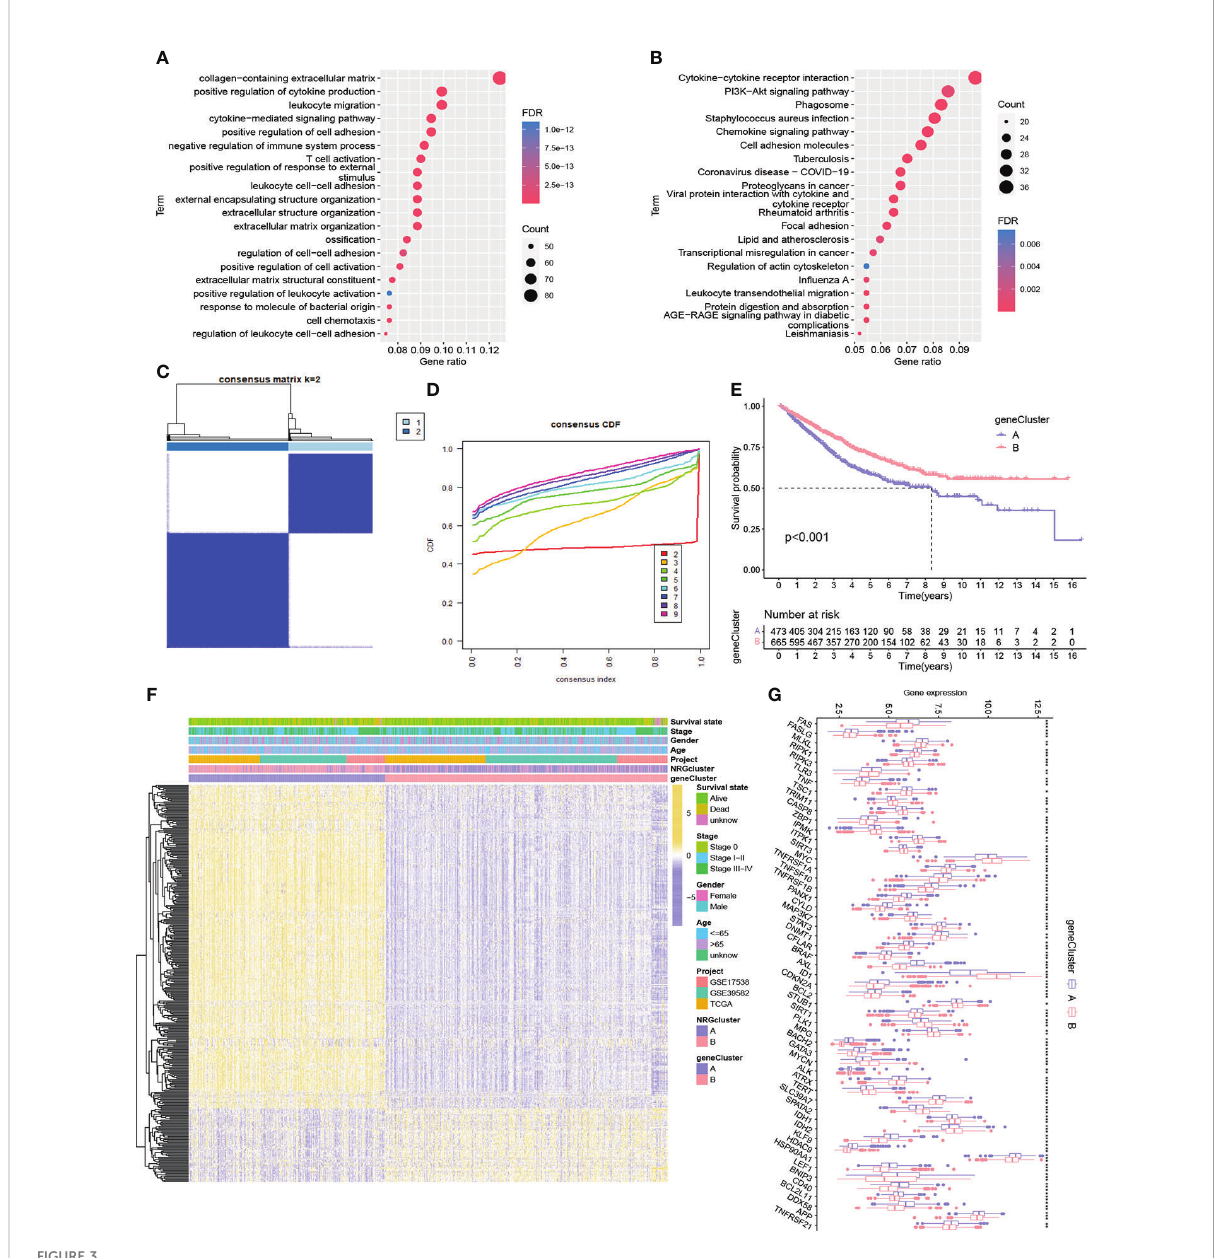
FIGURE 3 Identi fi cation of two gene subtypes. (A-B) GO and KEGG enrichment pathway of differentially expressed genes between two NRG subtypes. (C) Consensus matrix heatmap of sample clustering under k = 2. (D) CDF curve with the number of subtypes k = 2 to 9. (E) Survival analysis of patients in two gene clusters. (F) Heatmap showing differences in the expression of necroptosis-related signature genes between distinct gene clusters. (G) Differences of 67 NRG expression between two gene clusters. ***P < 0.001; **P < 0.01; *P < 0.05; ns P ≥